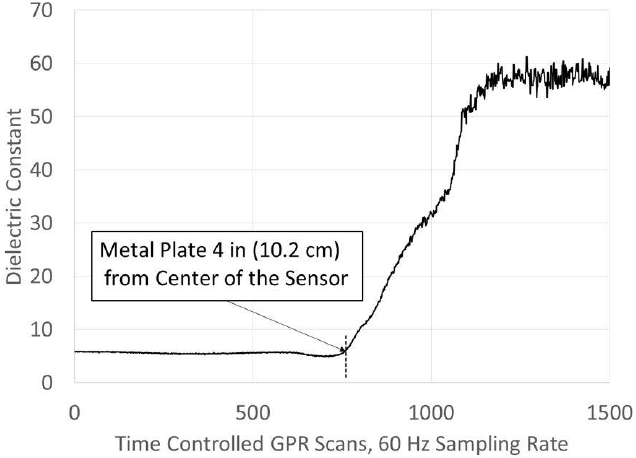
Figure 3. Experimental data confirming the first Fresnel zone approximation applies to the GPR antenna.